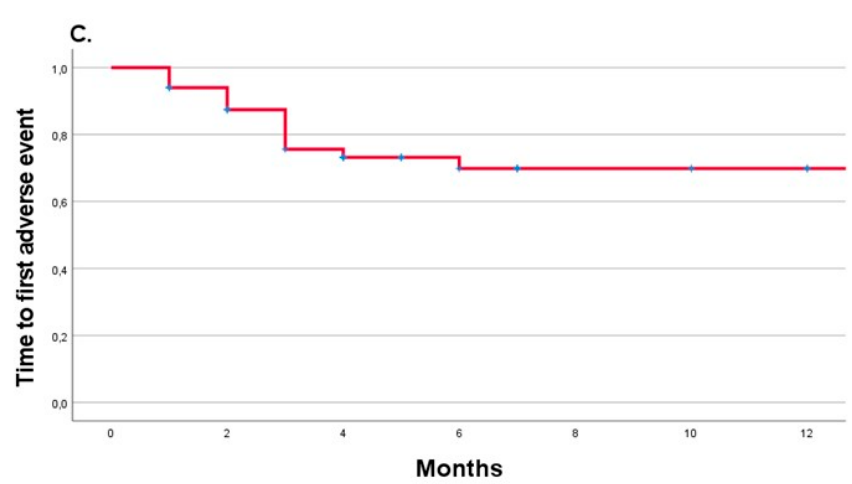
Figure 4. Kaplan-Meyer curves for overall survival ( A ) and progression-free survival ( B ), depending on the presence of adverse events and the time to occurrence of the first adverse event ( C ).